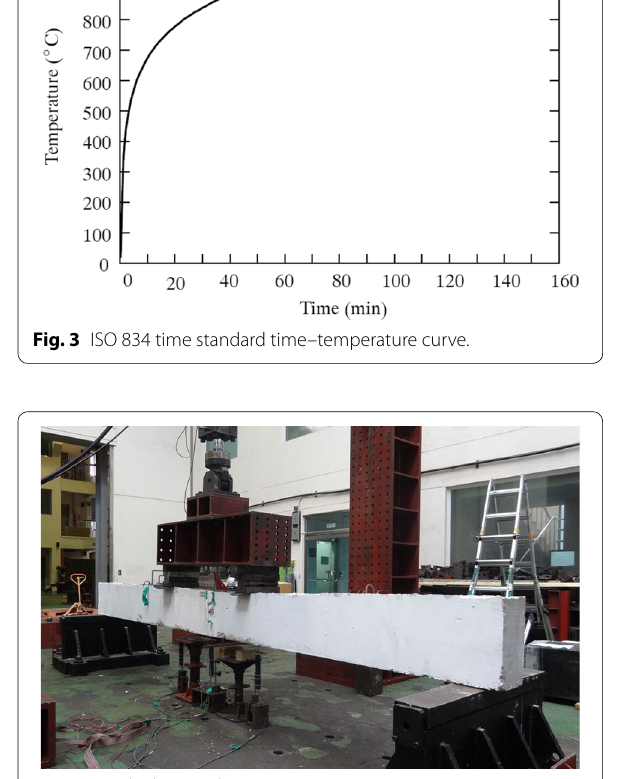
Fig. 4 Residual strength test.